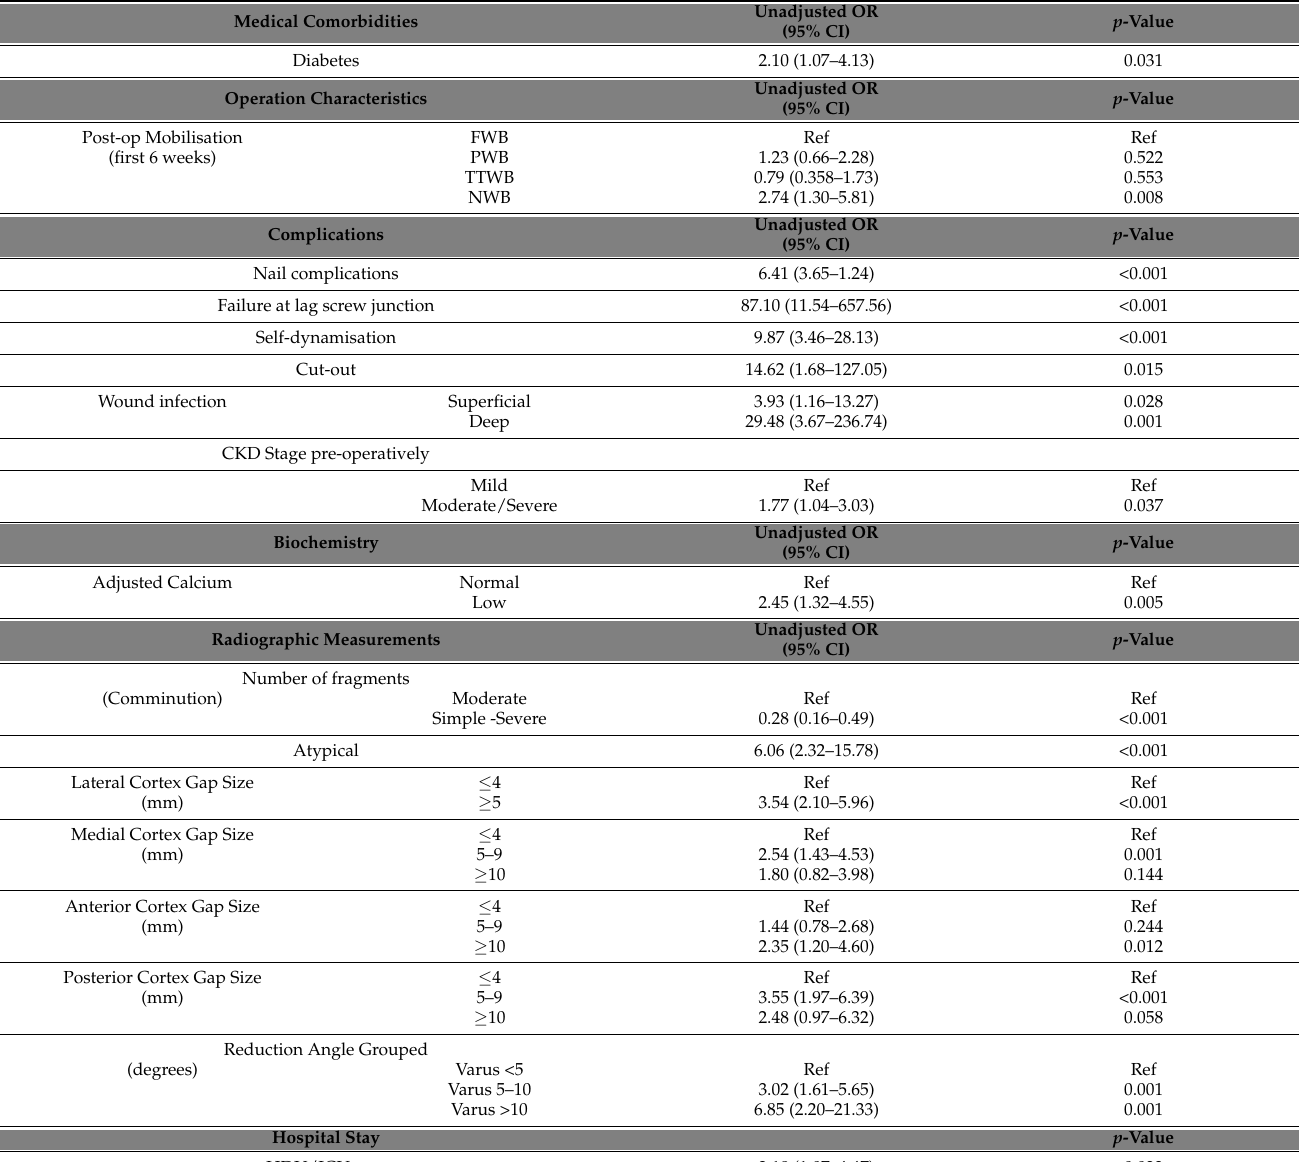
Table 2. Unadjusted associations with progression to